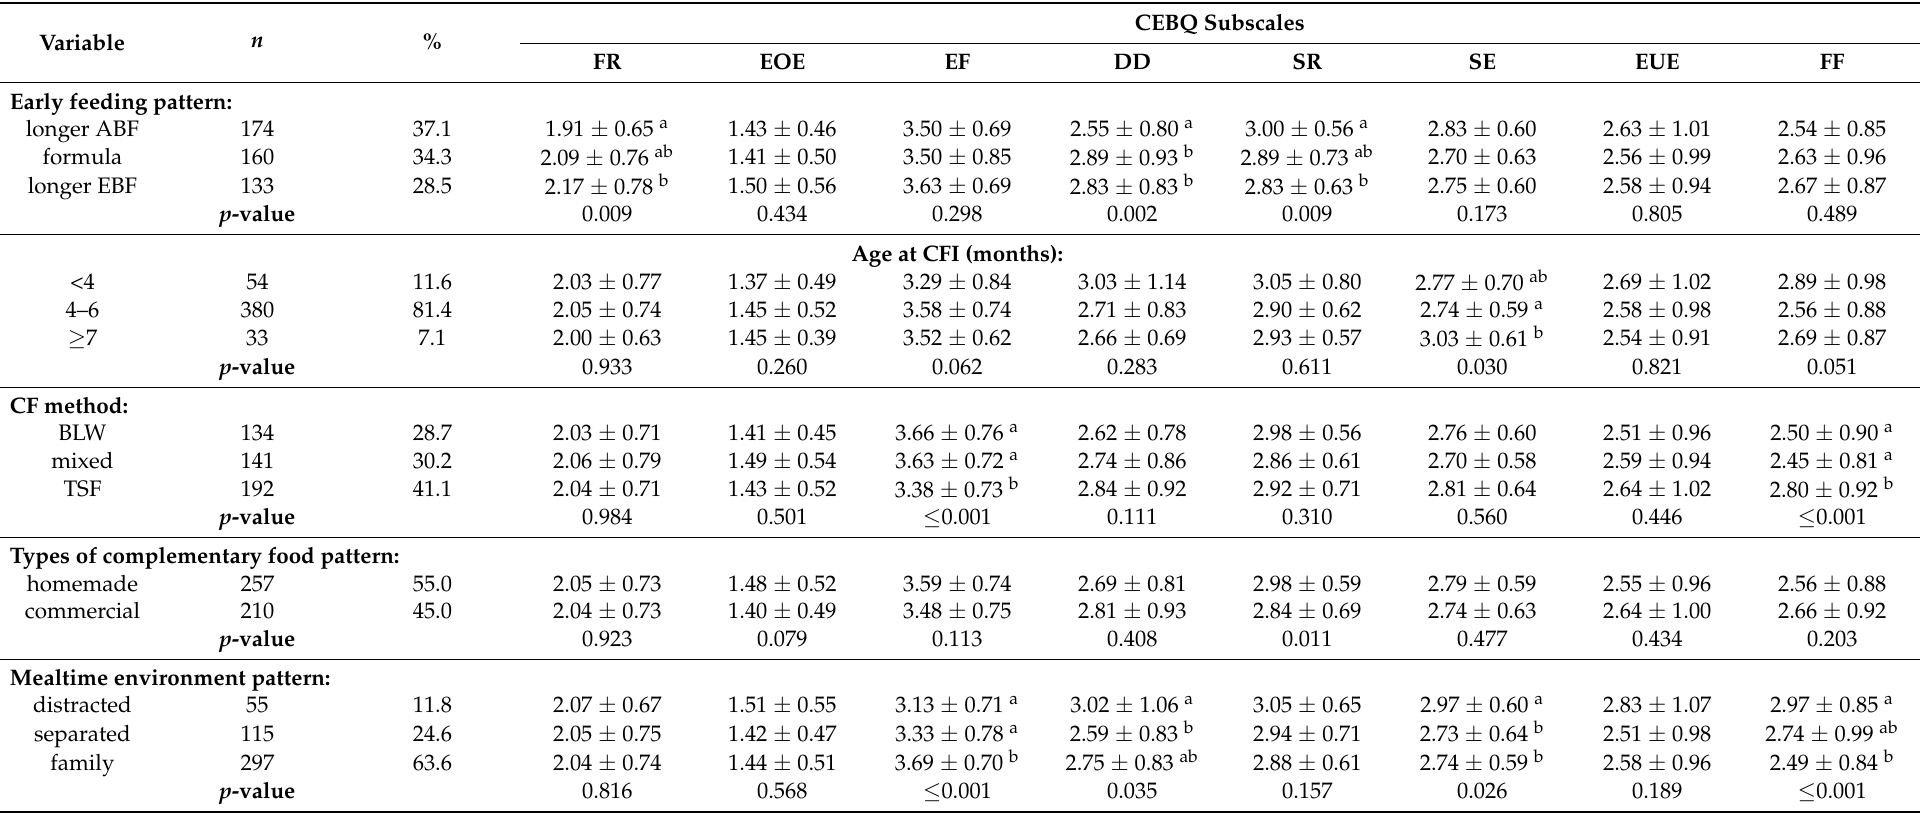
Table 2. Early feeding practices according to CEBQ